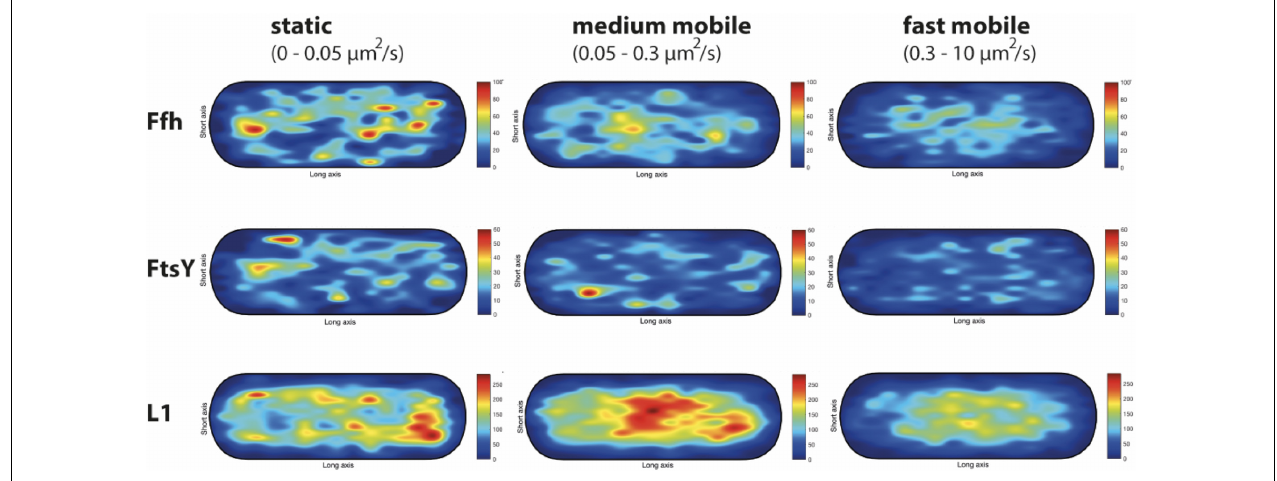
FIGURE 9 | Heat maps of the preferred localization of the three distinct populations of molecules. Localization heat maps with the localization of the tracks according to their apparent diffusion D* from MSD plots, where MSD ( (cid:52) t ) = 4 · D ∗ (cid:52) t. Linear fit was applied to the first 4 points of the MSD curve. A minimum of Pearson R squared of 0.8 was required. Among conditions, all heat maps have the same number of tracks (in brackets below the protein name) with approximately the same amount of detections (noted as N in the X axis label). Static fraction = D between 0 and 0.05 µ m 2 /s, medium mobile = D between 0.05 and 0. 3 µ m 2 /s, high mobile = D 0.3–10 µ m 2 /s. Colors from blue to red indicate increases in occupancy of tracks. Cells have a size of 1 × 3 µ